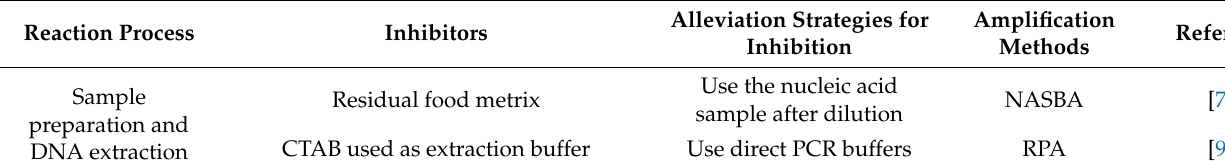
Table 3. Inhibitors from the isothermal amplification reaction